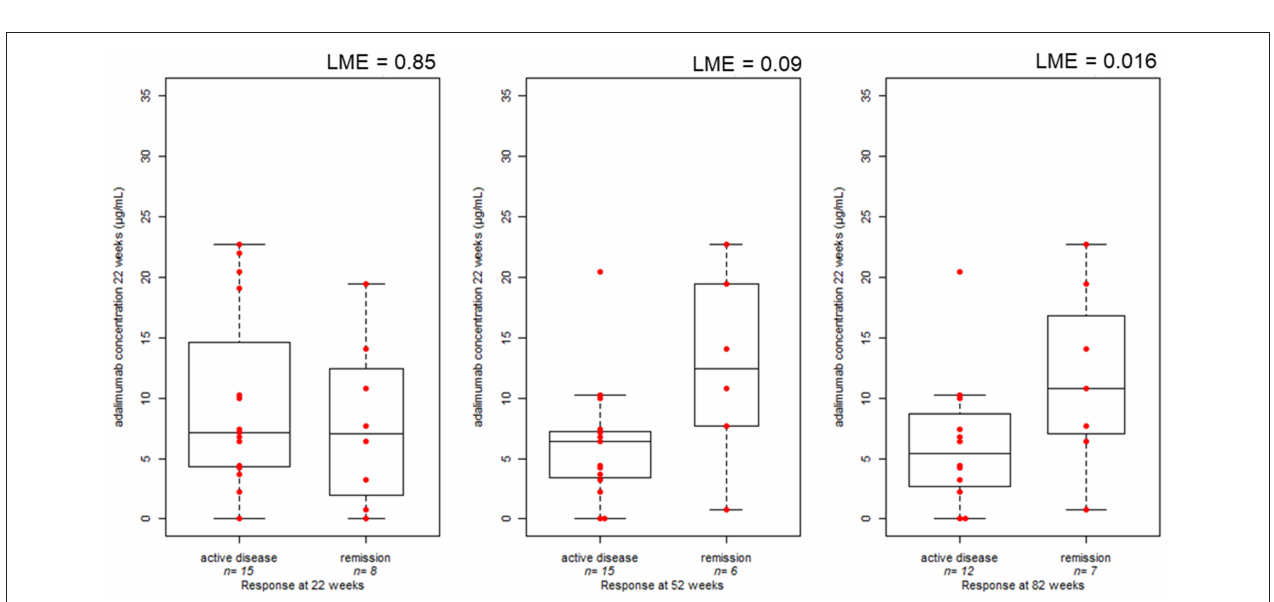
FIGURE 2 | Boxplot comparing clinical disease activity at 22 (23 measurements in 19 patients), 52 (21 measurements in 18 patients), and 82 (19 measurements in 16 patients) weeks of treatment and serum adalimumab concentration during week 22. The bold horizontal line represents the median value. P -values are from linear mixed effect model (LME), accounting for repeated measures.